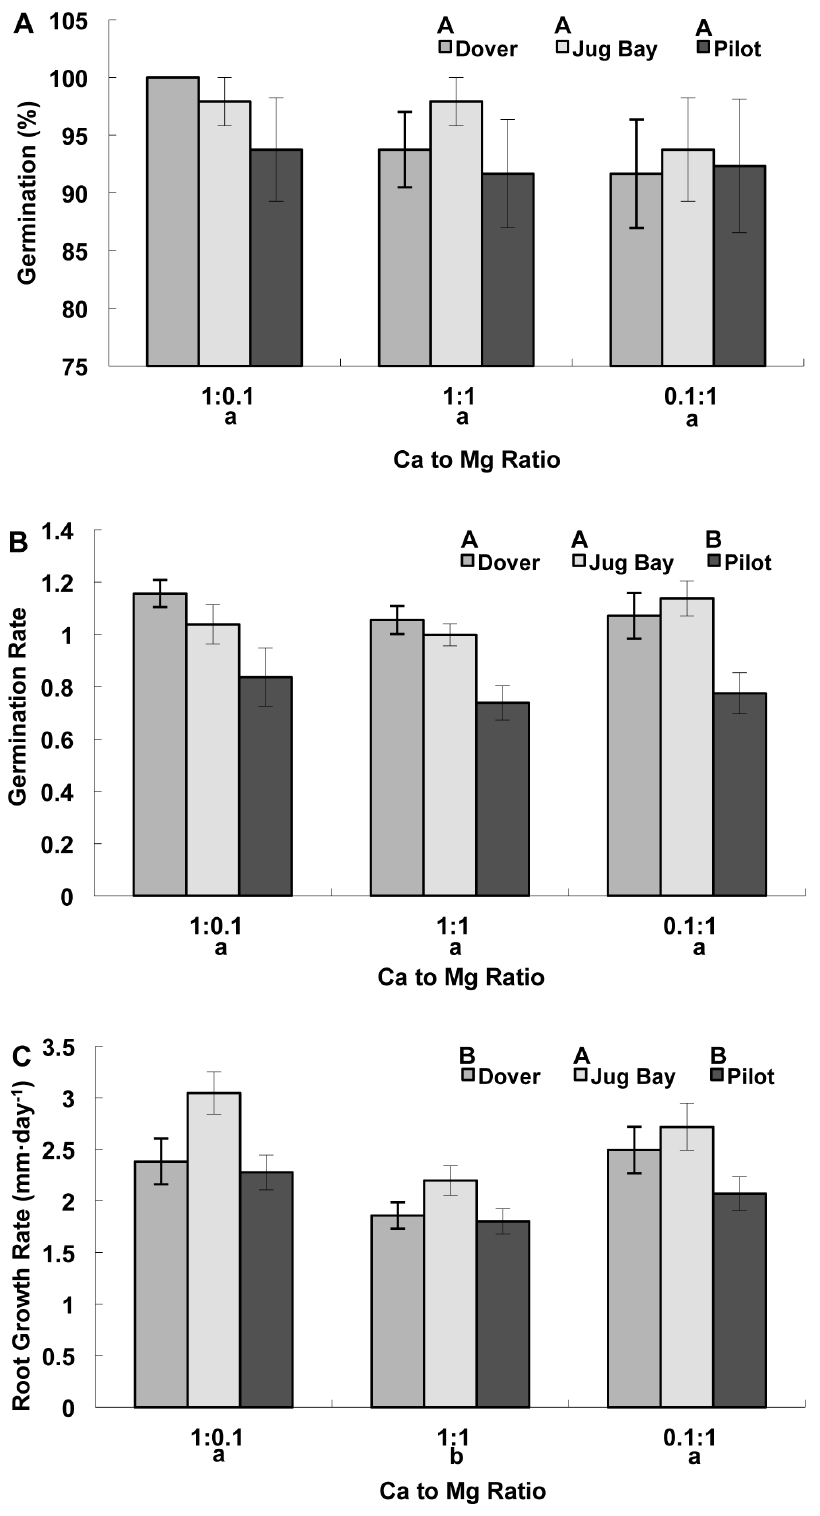
Figure 1. Seed germination and seedling root growth of three A.l. ssp. lyrata populations. A. Germination percentage, B. Germination rate, and C. Seedling root growth rate. All data are presented as a mean 6 standard error (n=12). The seeds were from serpentine (Pilot), limestone sand (Dover), and sandy loam (Jug Bay) soils. Different upper case letters indicate significant differences among populations, and different lower case letters indicate significant differences among substrate Ca to Mg ratios as separated by Tukey’s HSD (P , 0.05).